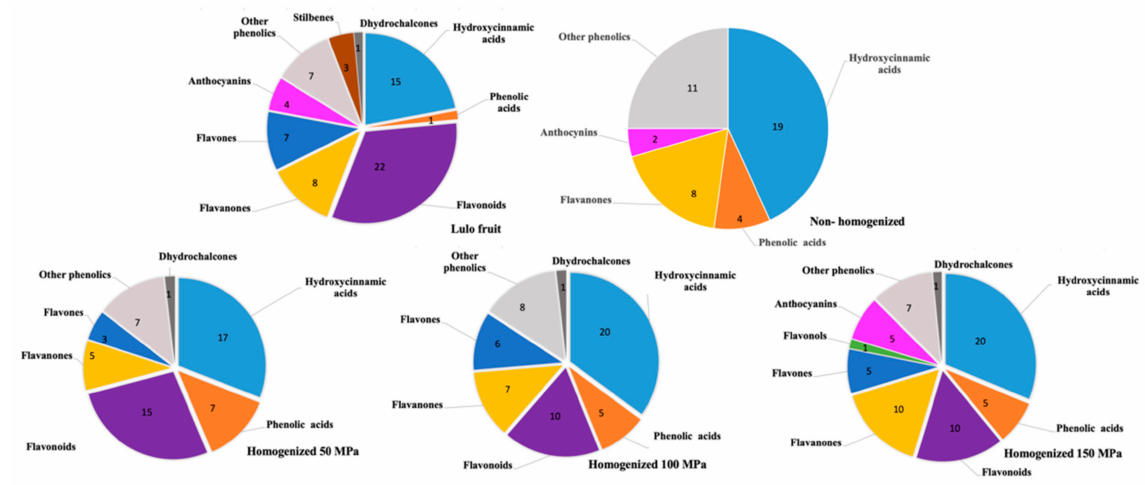
Figure 4. Percentage distribution of phenolic compounds identified in lulo fruit, nonhomogenized, and homogenized lulo